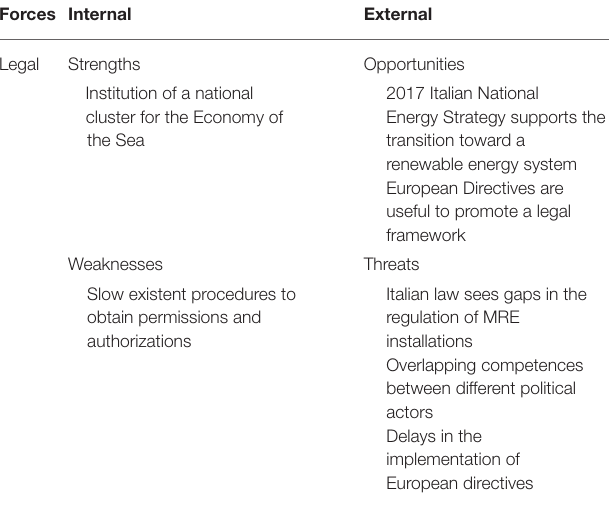
TABLE 3 | SWOT analysis of legal factors.